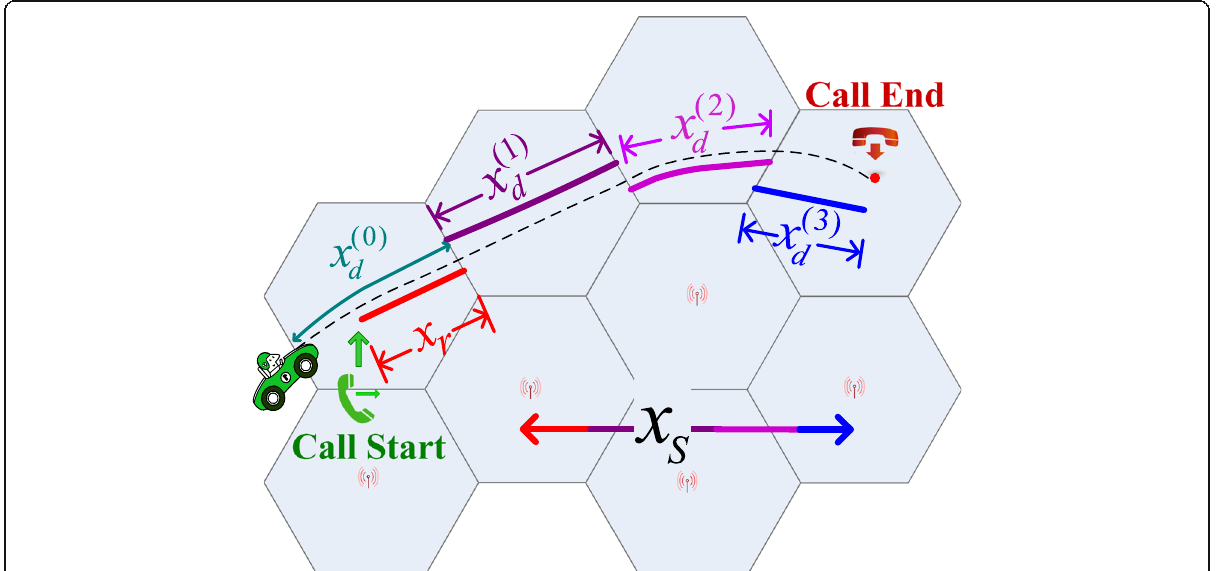
Fig. 2 Relationship between the cell residence and service times for successfully completed calls